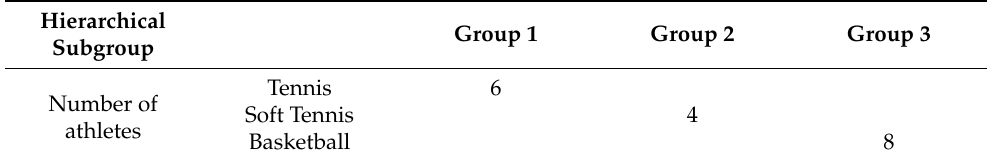
Figure 2. Aggregate hierarchical clustering results for the performance of 18 samples. Table 3. Comparison of hierarchical clustering results.